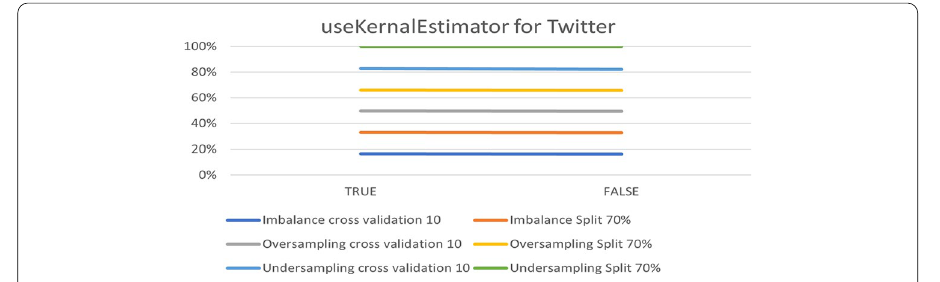
Fig. 15 The accuracy of useKernalEstimator for NB in Twitter